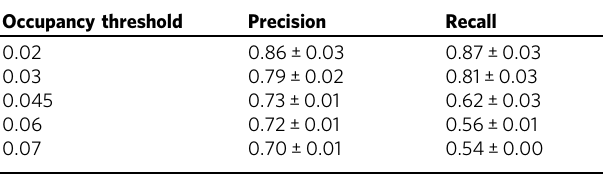
Table 2 Precision and recall of convolutional neural